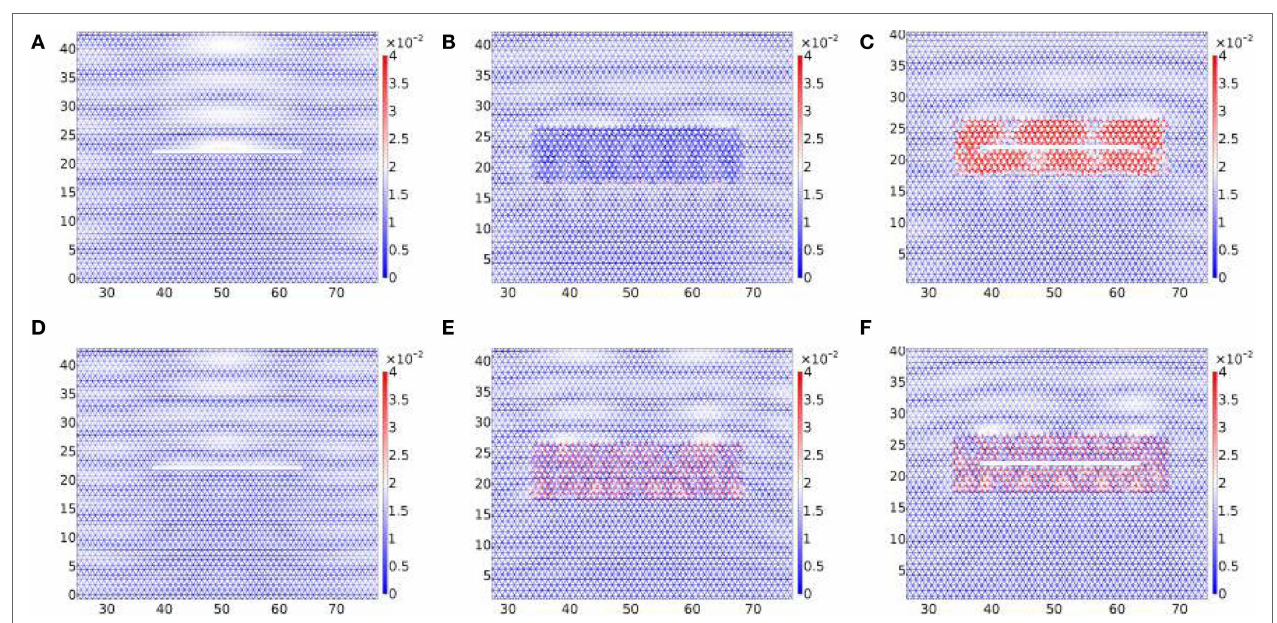
FIGURE 11 | The harmonic response to a shear plane wave. Panels (A,D) , (B,E) , and (C,F) comprise a crack, a cluster of resonators, and a crack surrounded by a cluster of resonators, respectively. The angular frequency for panels (A–C) is ω = 2.1rad/s corresponding to the lower edge of the band gap of Figure 3A . The shear wave’s angular frequency for panels (D–F) is ω = 2.7rad/s corresponding to the upper edge of the band gap of Figure 3A .